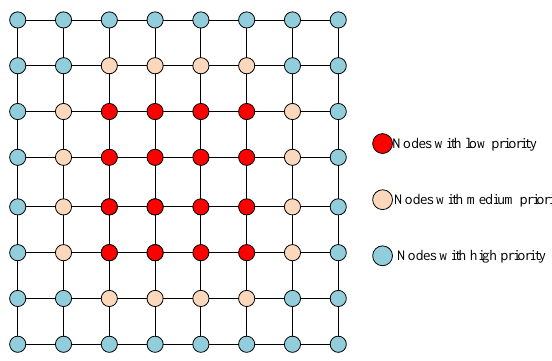
Figure 2. The priority of the nodes in an 8 × 8 2D Mesh